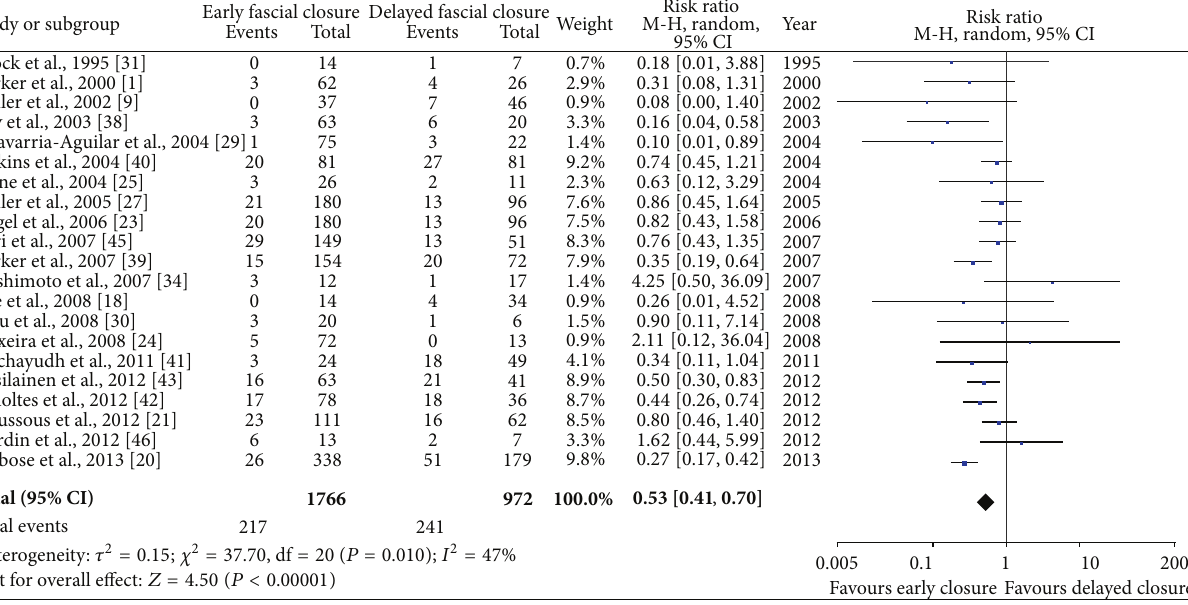
Figure 1: Early fascial closure versus delayed abdominal closure for mortality rate.